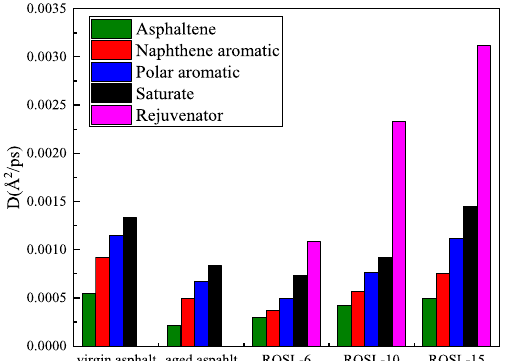
Figure 12. Molecular diffusion coefficient of asphalt components.